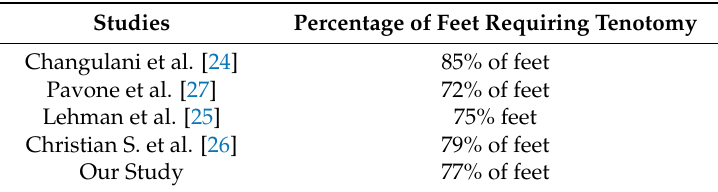
Table 7. Comparison of tenotomy with other studies.